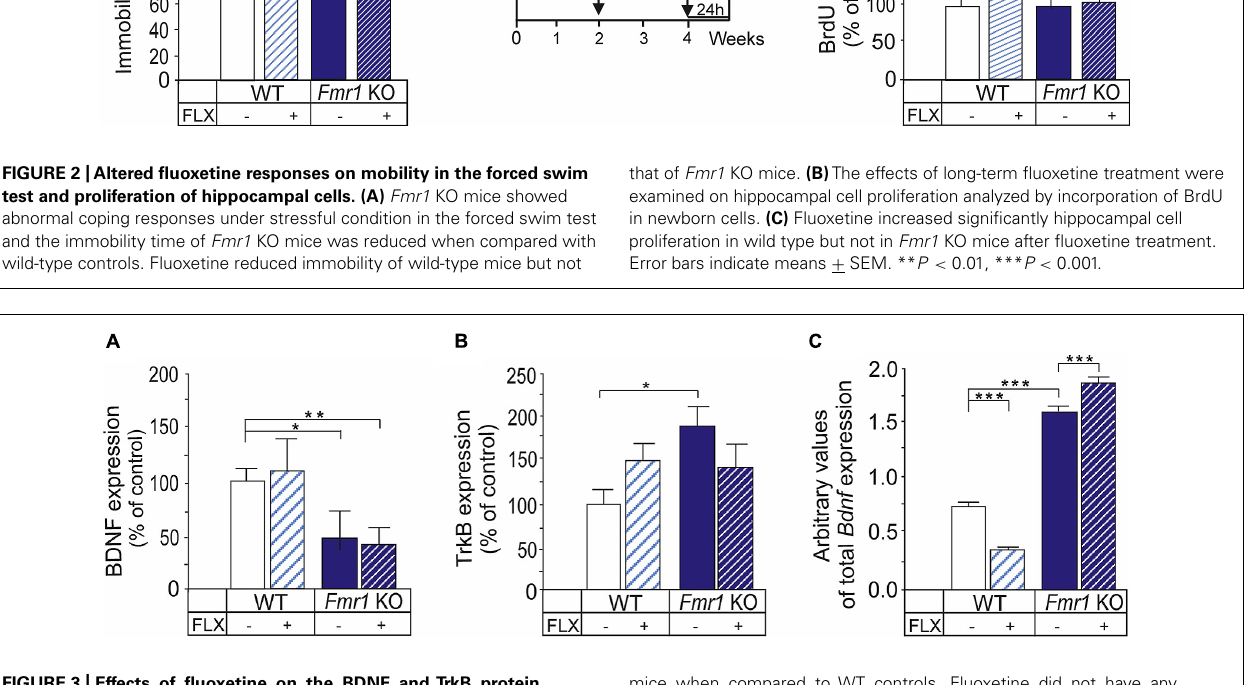
FIGURE 3 | Effects of fluoxetine on the BDNF and TrkB protein expression in the hippocampus of Fmr1 KO mice. (A) The BDNF protein expression was reduced in the hippocampus of Fmr1 KO mice ( Fmr1 KO) when compared to that of wild-type mice (WT). The expression levels were not changed significantly after treatment with fluoxetine under our experimental conditions. (B) The TrkB receptor protein was significantly increased in the hippocampus of Fmr1 KO